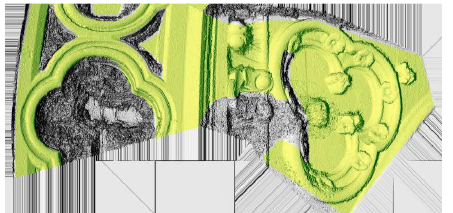
Figure 8: The green area represents the reliable part of the depth map 30 depth maps were computed with the 15 mm focal length images (Figure 9 and